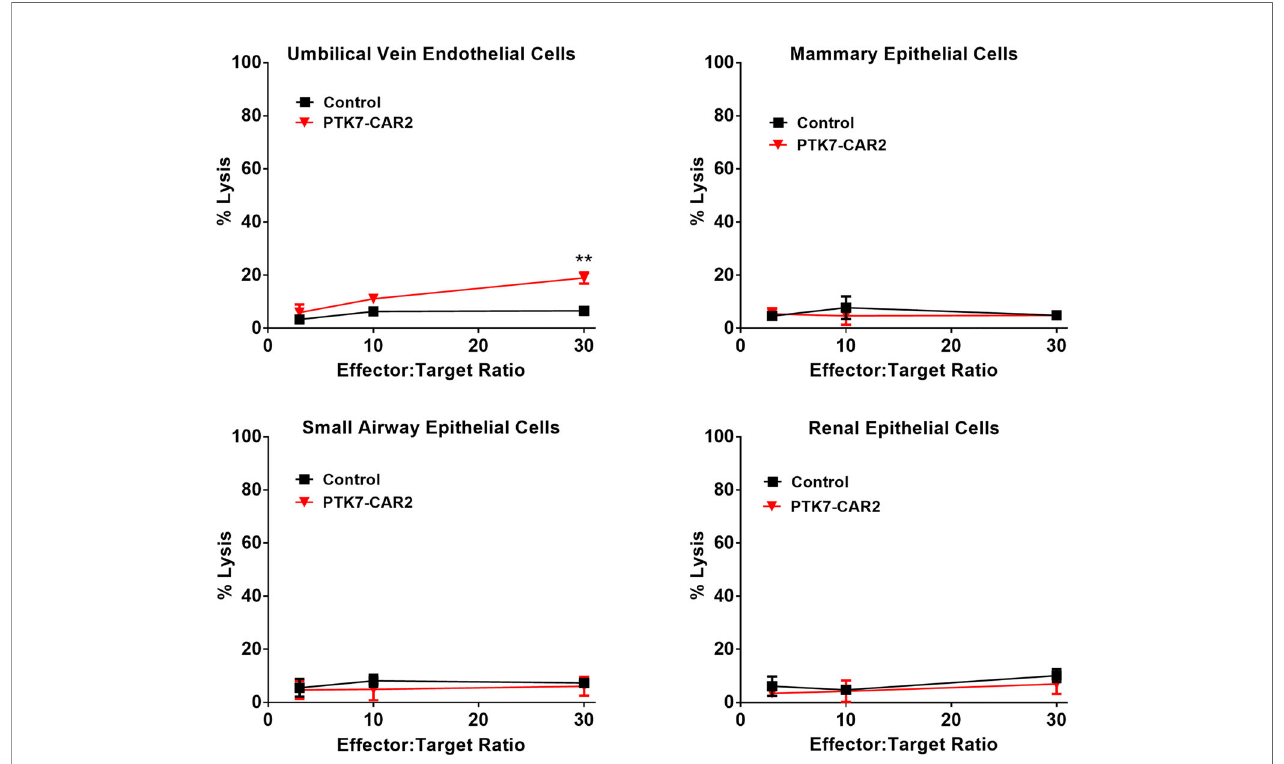
FIGURE 7 | PTK7-CAR2 T cells do not mediate detectable on-target off-tumor toxicity. Control or PTK7-CAR T cells were tested reactivity against a panel of primary human normal epithelial cells or HUVECs in the cytotoxicity assays at the indicated effector-to-target ratios. Shown are mean ± SEM of % cell killing in triplicate wells. **P < 0.01, determined by repeated-measures two-way ANOVA with Tukey ’ s post hoc